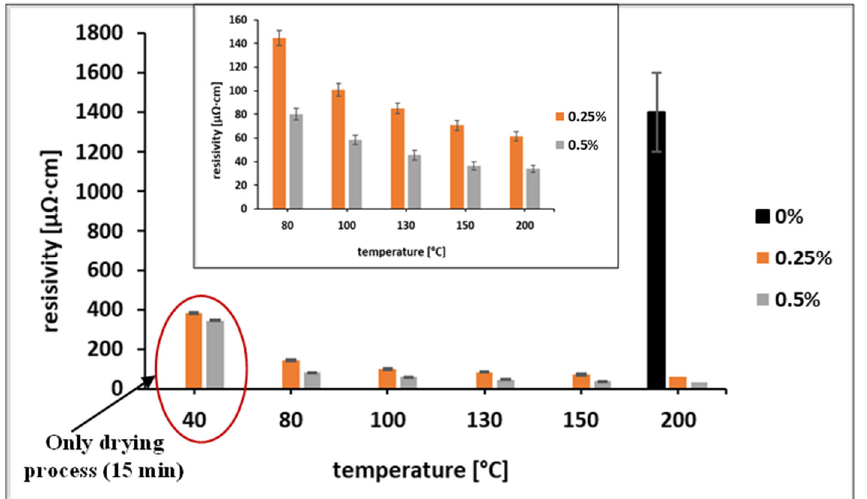
Figure 3. Resistivity of coatings formed by Ni@Ag NPs inks containing 0.25 and 0.5 wt% OA as a function of sintering temperature in the range of 40–200 °C (heating duration 30 min). Black bar represents resistivity of ink coatings without OA.